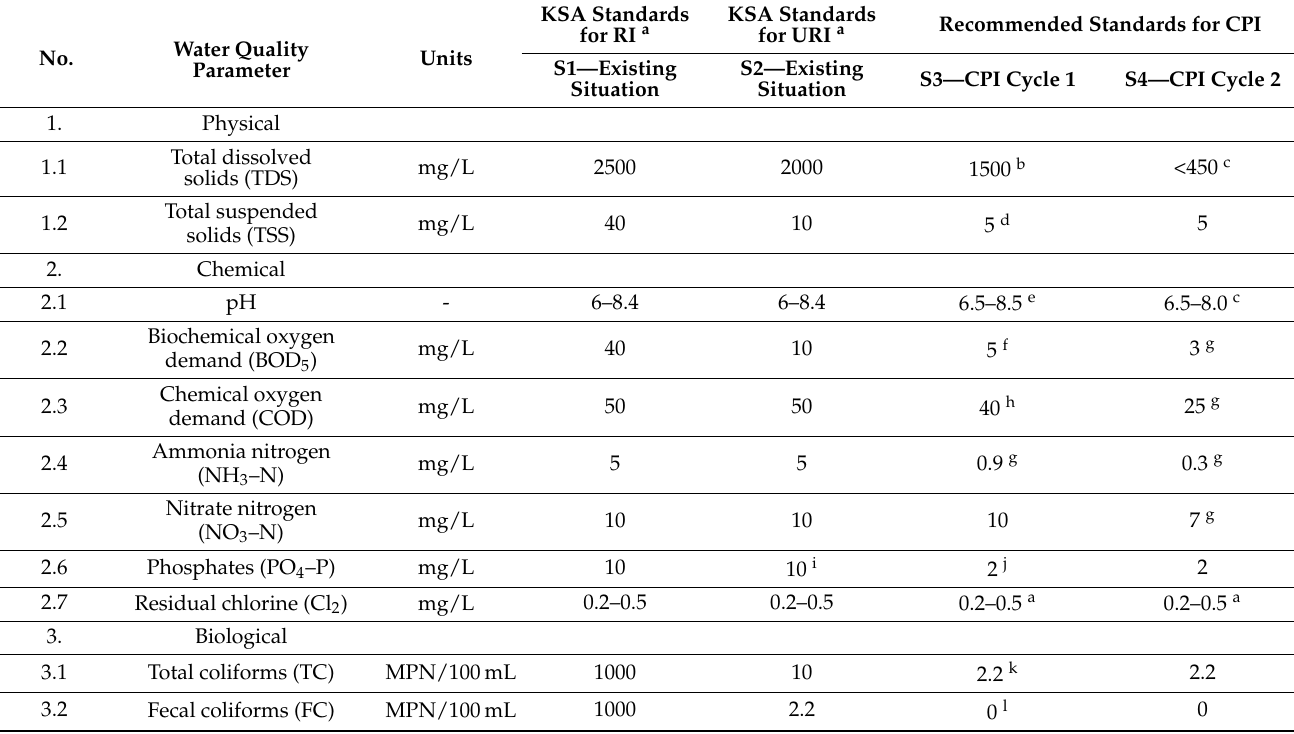
Table 2. Standards and guidelines for reuse of treated